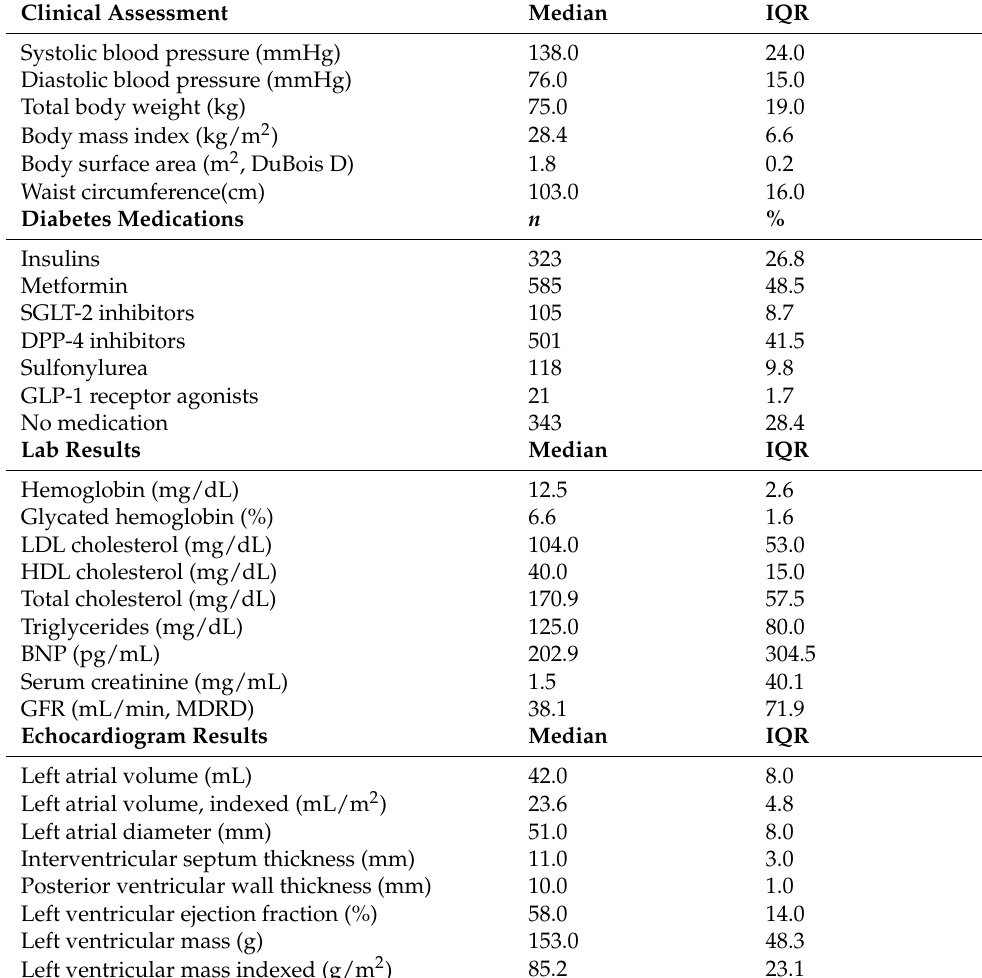
Table 3. Clinical assessment, laboratory test and echocardiogram results, and diabetes medication of patients with heart failure and type 2 diabetes